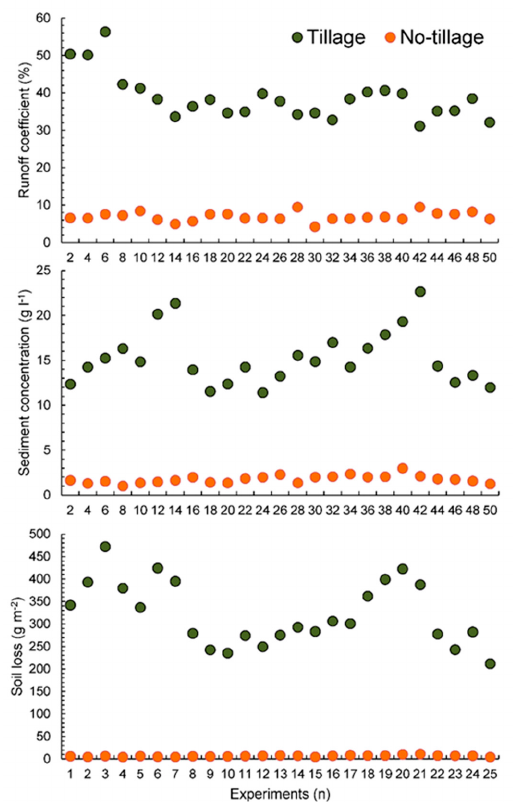
Figure 7. Soil hydrological and erosional response along the two inter-rows studied using simulated rainfall experiments. The distance between the plot was 2 m. A: Runoff coefficient (%); B: Sediment concentration (g L − 1 ) and, C: Soil erosion rate (g m − 2 ).